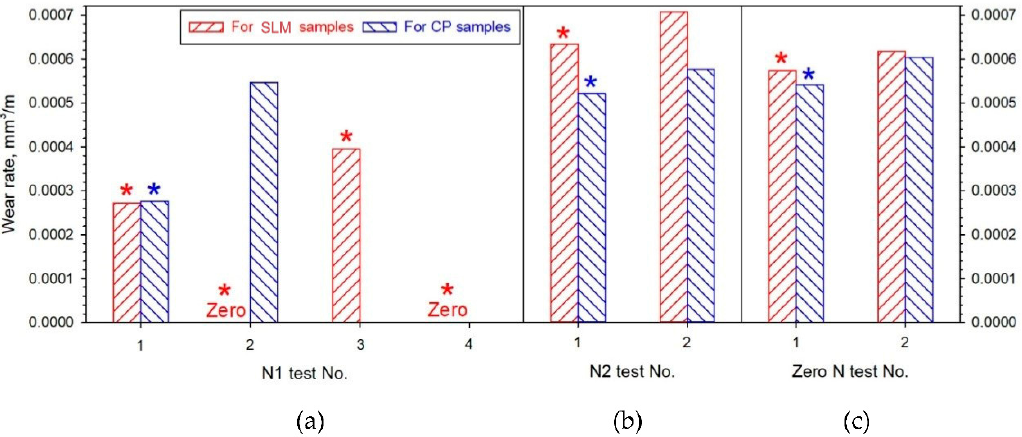
Figure 3. Wear rate of eight tests conducted with F = 1 N and f = 2 Hz for 40 m and on samples with ( a ) N1 and ( b ) N2 nitrogen concentration profile after ion implantation, and ( c ) with samples without ion implantation. Note: data with * mean their track appearances will be shown.